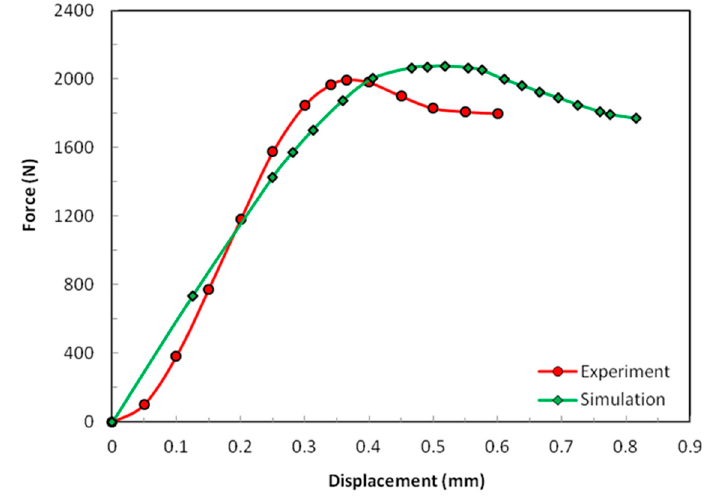
Figure 8. Compression results of the test and the simulation.